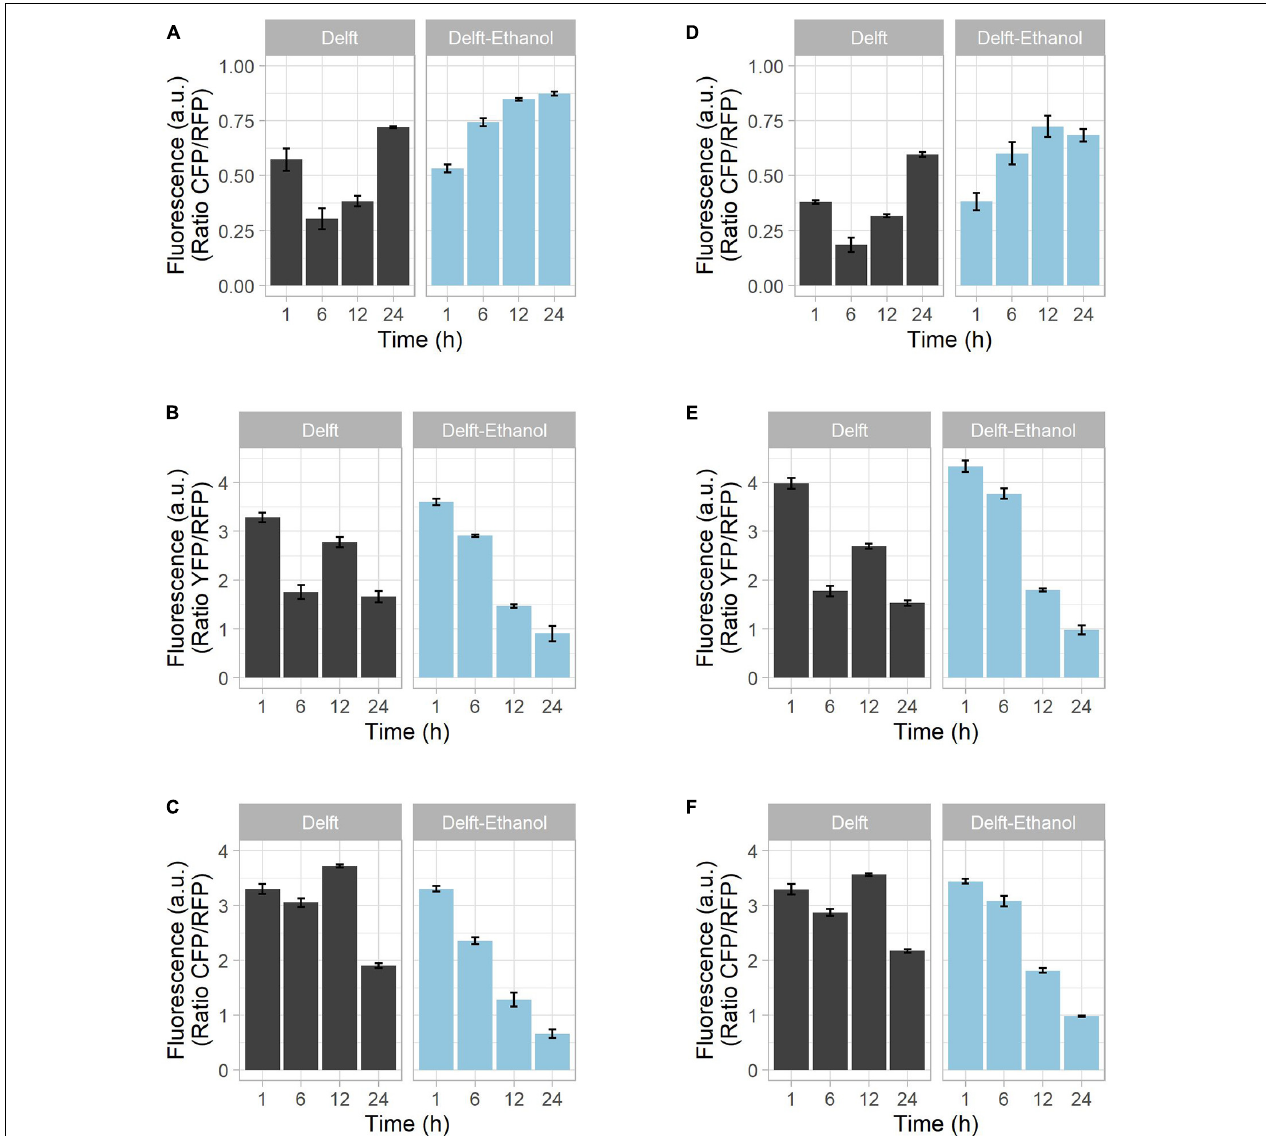
FIGURE 4 | Growth of strains on different carbon sources and biosensor combination. CEN.PK113-7D strains bearing biosensors were grown in synthetic minimal Delft medium containing either 20 g/L glucose (black bars) or 20 g/L ethanol (blue bars) as sole carbon source. Mutants with (A–C) a single biosensor or (D–F) pairs of biosensors were tested to determine the reliability of the fluorescence output. The tested intracellular parameters included (A,D) glycolytic flux (via GlyRNA and GlyOx), (B,E) oxidative stress (via OxPro and GlyOX), and (C,F) ribosome production (via RibPro and RibOx). Using glucose as carbon source, the time points denote lag phase (1 h), exponential phase (6 h), diauxic shift (12 h), and stationary phase (24 h). With growth on ethanol, time points denote lag phase (1–12 h) and active growth (24